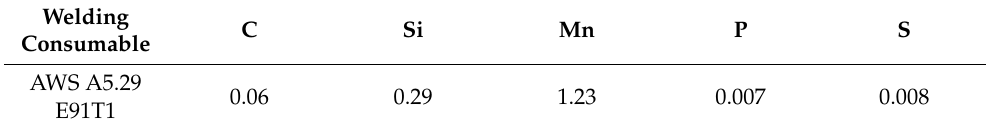
Table 4. Mechanical properties of the welding consumable (AWS A5.29 E91T1). Welding Yield Stress Consumable